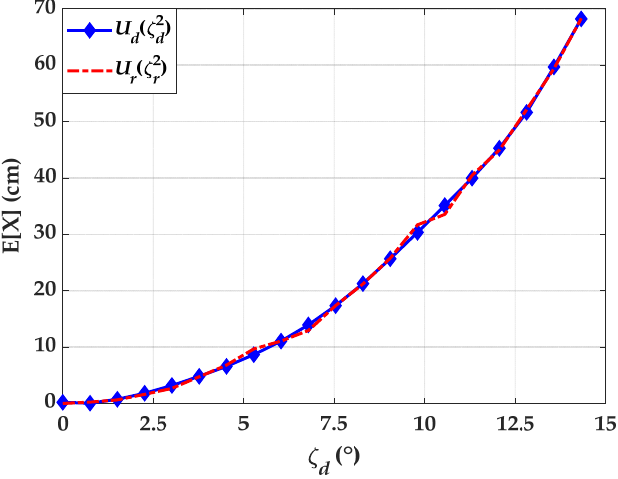
Figure 7. Study on Tx’s orientation uncertainty based on the direct and reverse processes.